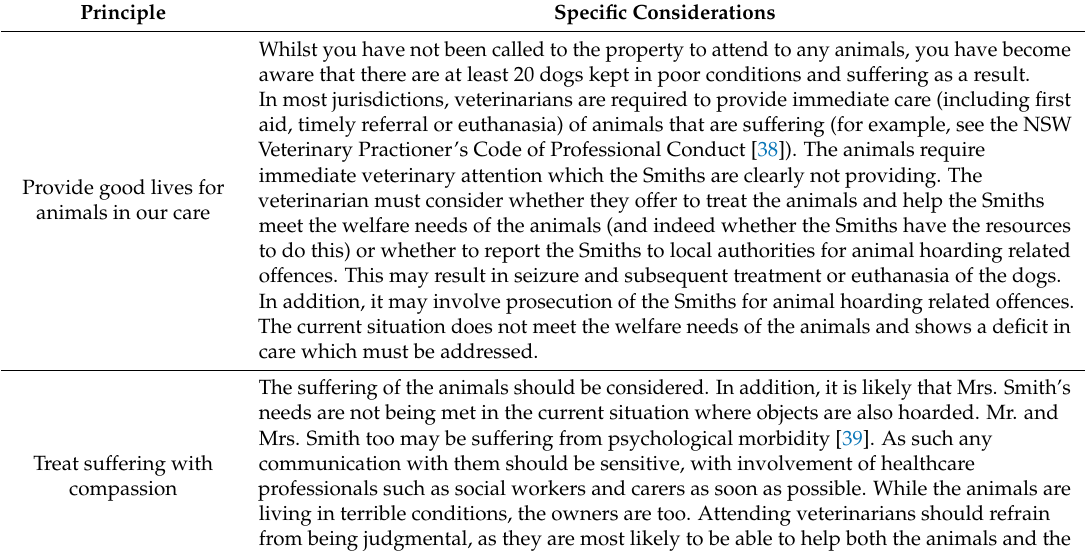
Table 2. Fraser’s “practical” ethic principles applied to animal hoarding